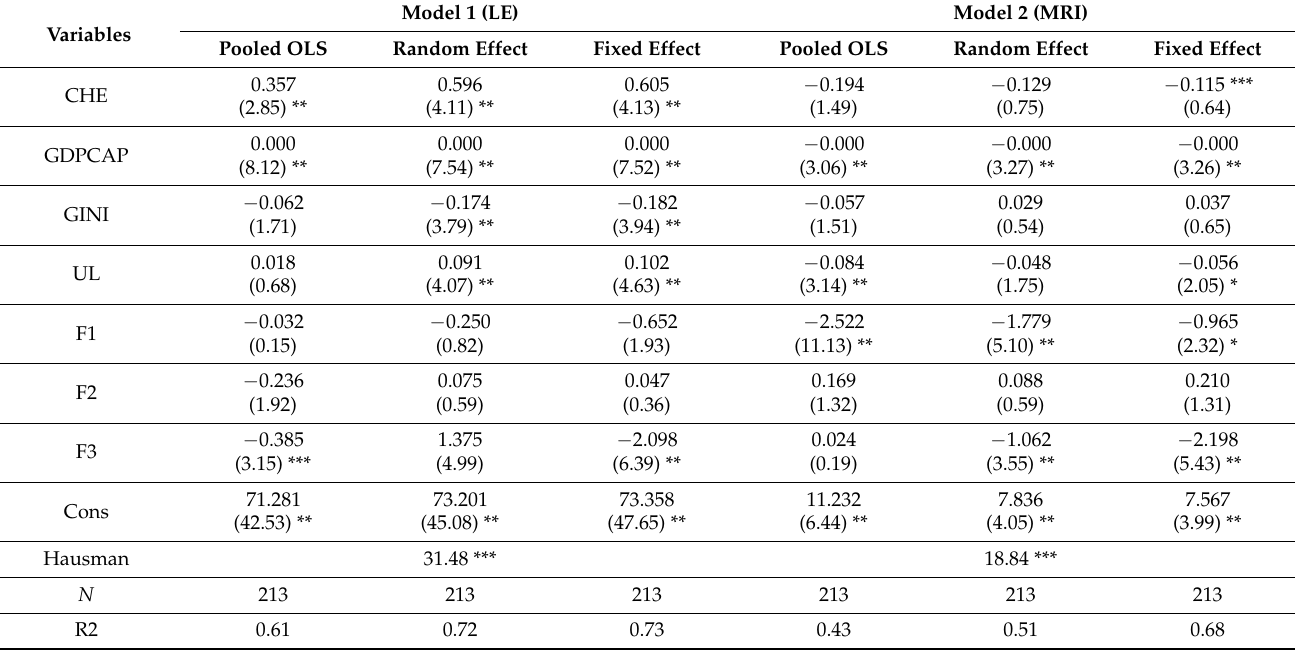
Table 1. The results of the mixed-effect